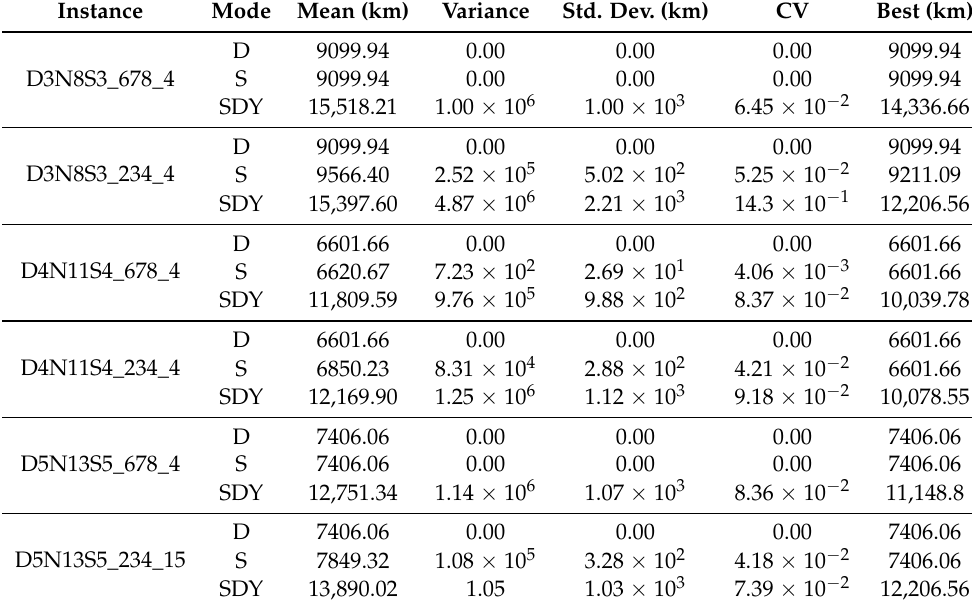
Table 11. Results of Total Distance Travelled with (Maximum) 4 Vehicles.